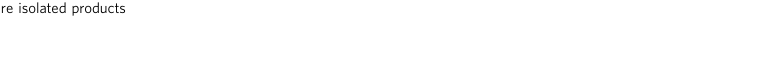
Standard conditions: see entry 5, Table 1. Yields shown are isolated products a Diastereoselectivity was determined by 1 H NMR